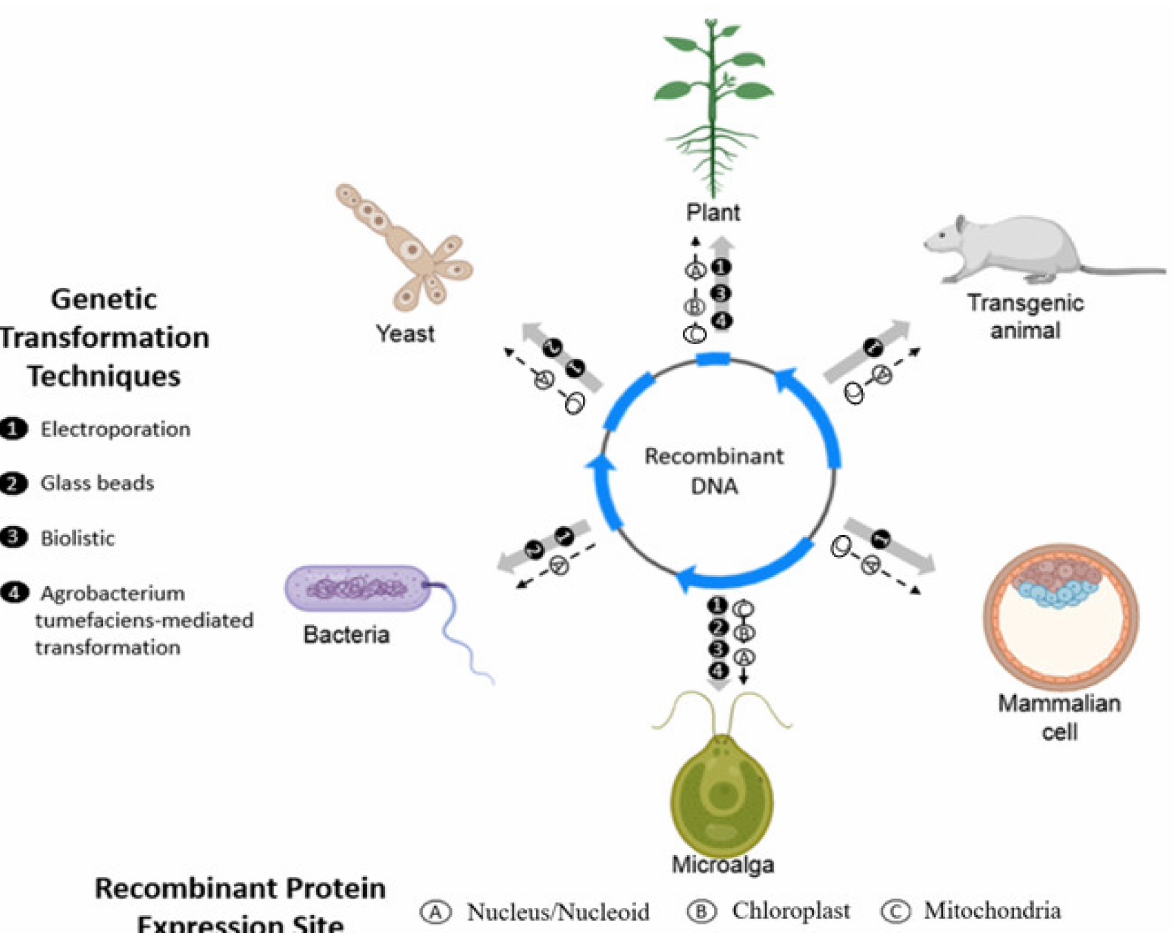
Figure 1. The main platforms used for the therapeutic proteins’ expression. Numbers 1 to 4 indicate the possible genetic transformation method used on each platform, all of which are also used on Chlamydomonas reinhardtii . Letters A to C indicate the organelles that can be genetically modified on each platform, which is also possible on